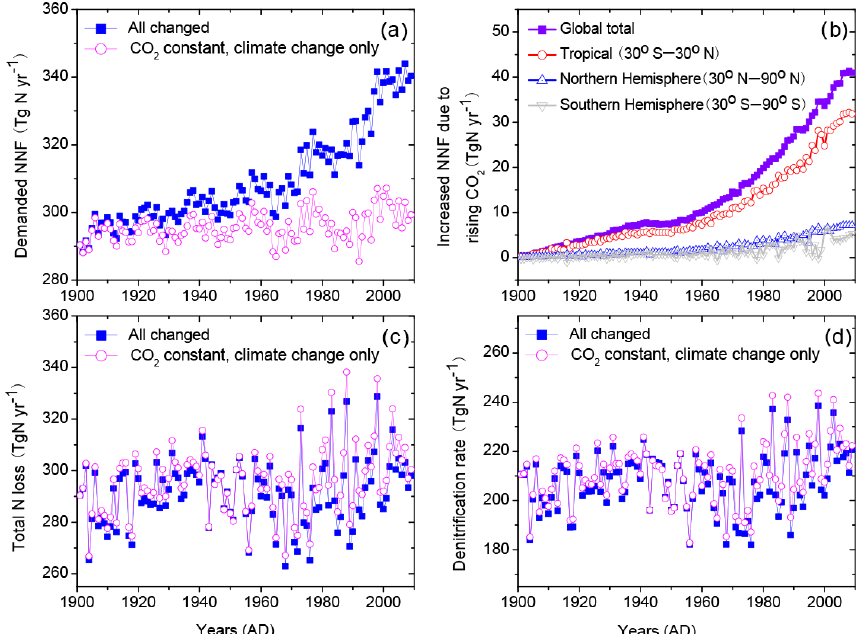
Figure 3. Transient simulations during the 20th century, with e = 0 . 175 and changes in CO 2 and climate or in climate alone. (a) Demand for